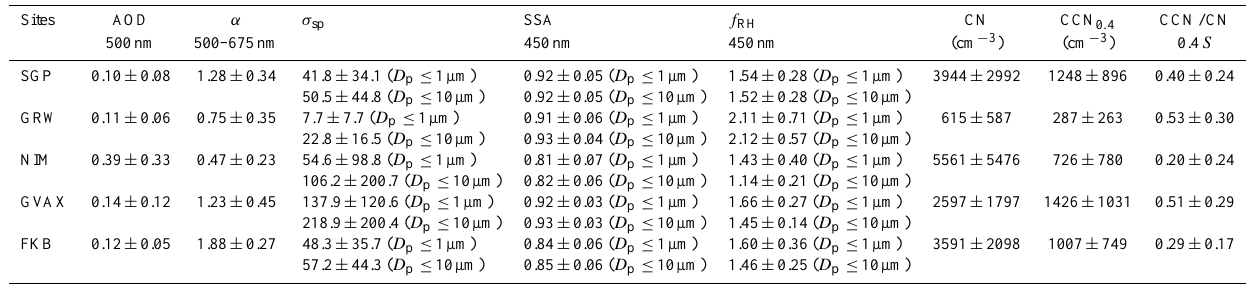
Table 2. Summary of mean aerosol optical quantities, CN concentration, and CCN concentration at 0.4% supersaturation during the study period.